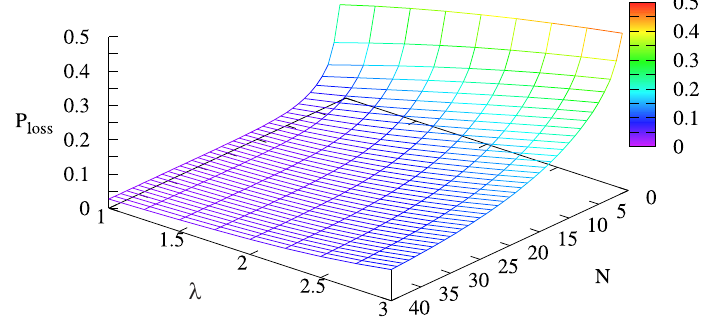
Figure 9. Dependence of the probability P loss on N and λ